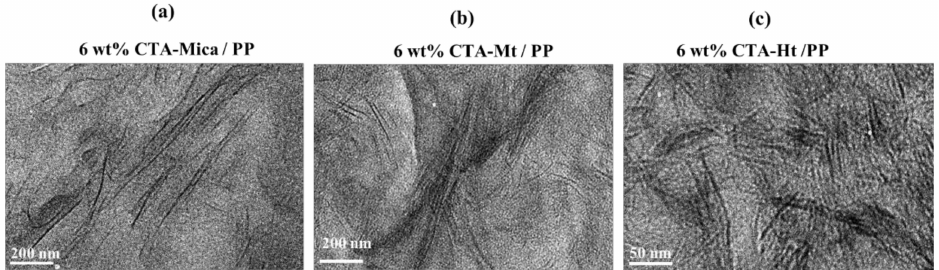
Figure 4. TEM images of ( a ) 6 mass % CTA-Mica/PP, ( b ) 6 mass % CTA-Mt/PP, and ( c ) 6 mass % CTA-Ht/PP nanocomposites.